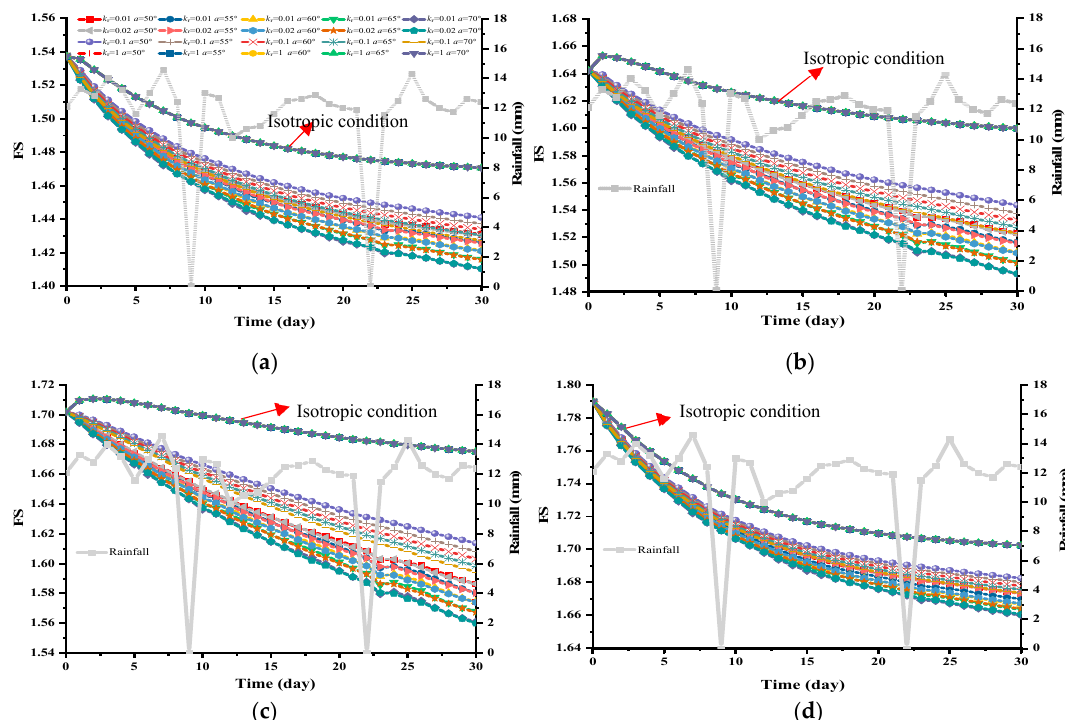
Figure 14. Variations in the safety factors during rainfall: ( a ) 284 sliding surfaces; ( b ) 293 sliding surfaces; ( c ) 313 sliding surfaces; ( d ) 112 sliding surfaces.